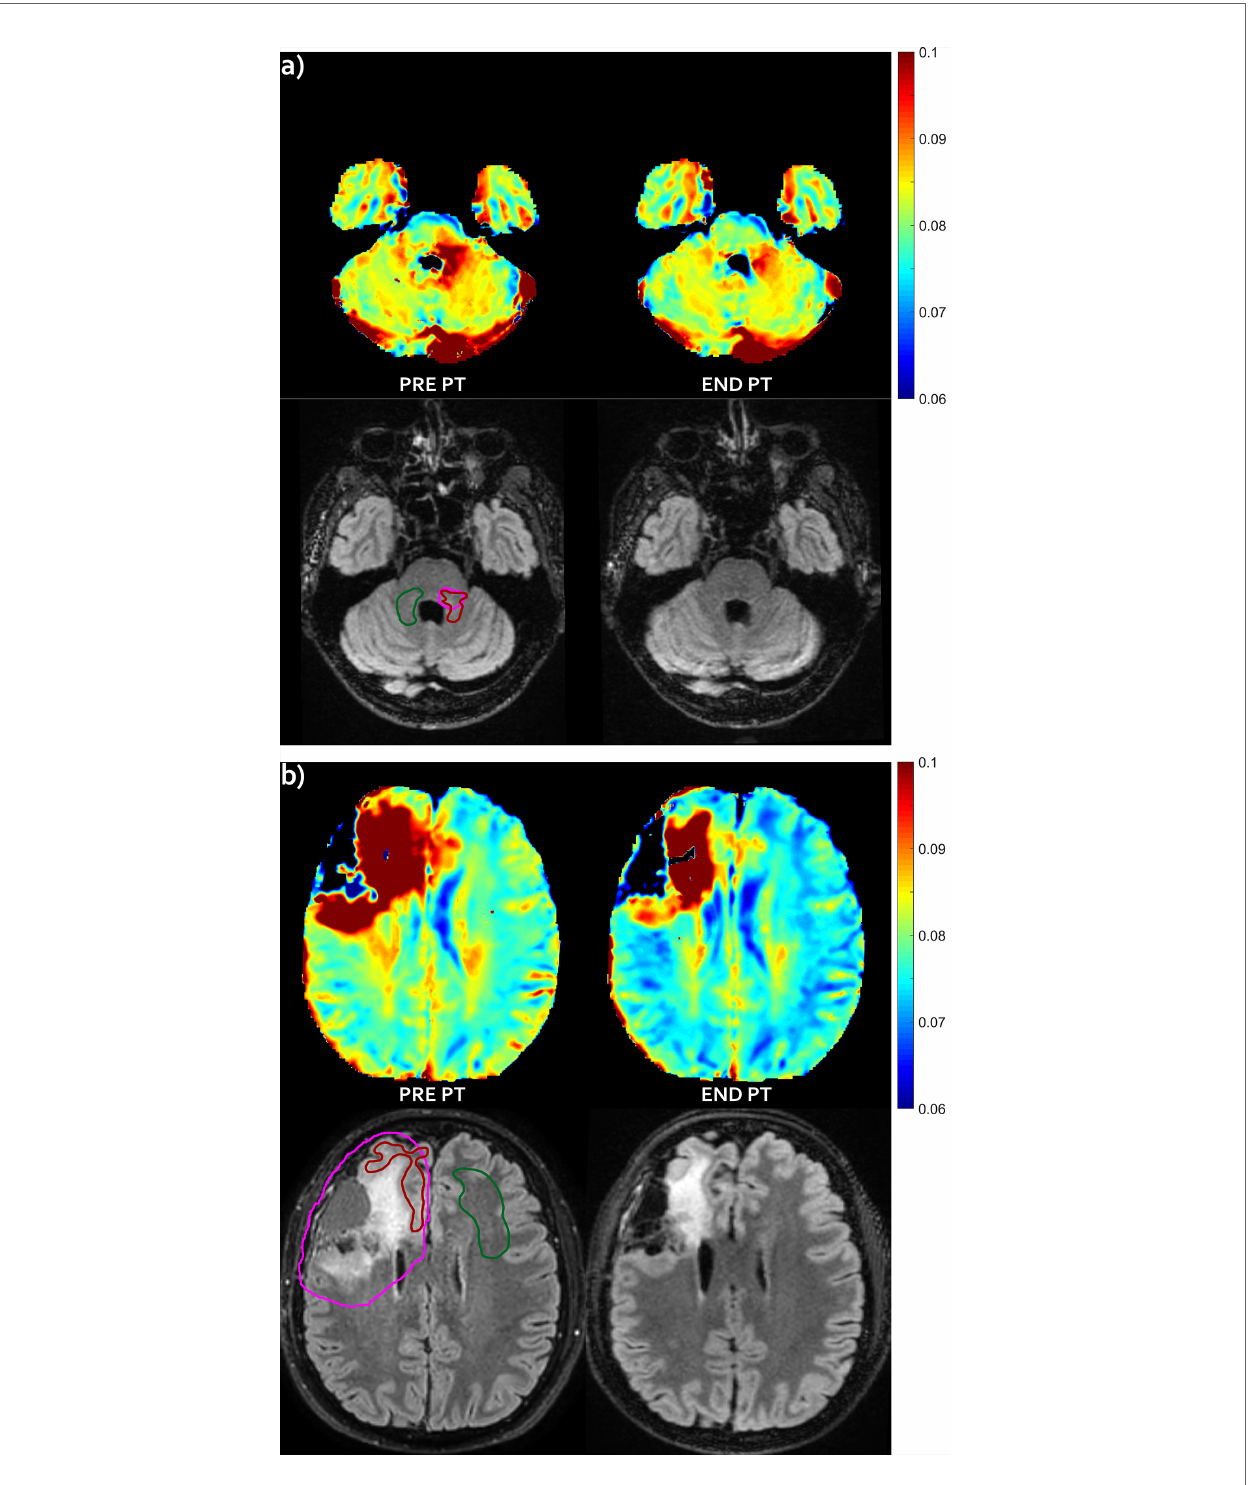
FIGURE 1 | T2 decrease pattern — Evolution pattern observed in patient #1 (A) and #5 (B) . The mismatch, i.e. abnormal T2 area that extended outside the hyper- intense FLAIR area before proton irradiation (left) markedly reduced at the end of the radiation treatment (right), with no appearance of successive FLAIR hyper- intensity in this region (not shown). For patient #1, no FLAIR abnormality was visible in panel (A) , but it was visible at a different slice level (not shown). T2 intra/ extracellular water maps (top) and FLAIR images (bottom) are shown. Colored bar is shown in seconds. On pre-PT FLAIR image the contours of the CTV (violet line), of the mismatch ROI (red line) and of the contralateral healthy ROI (green line) are